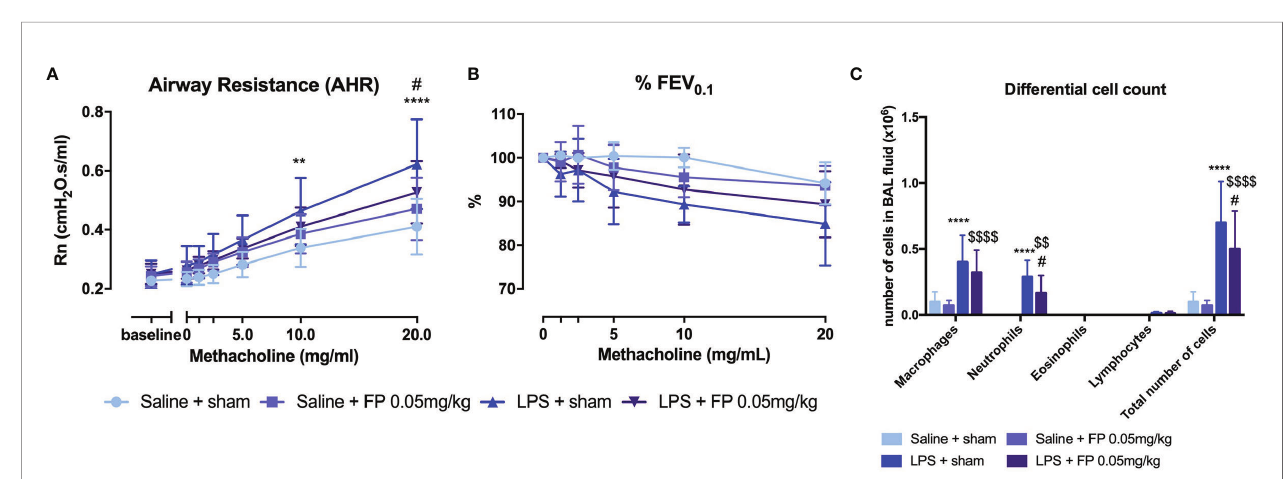
FIGURE 3 | Effect of glucocorticoid treatment in the LPS-induced asthma model. BALB/c mice were exposed to LPS (2 µg in 50 µl saline) and fl uticasone propionate (FP at 0.05 mg/kg in 50 µl) via the nose as shown in Supplementary Figure 1D . Forty-eight hours after the last challenge with LPS, lung function parameters were measured using the FlexiVent and BAL fl uid obtained for differential cell count. Airway resistance [Rn, (A) ] and FEV 0.1 [%, (B) ] before and after methacholine provocation (0 – 20 mg/ml) were measured in saline + sham-treated mice (n = 8), saline + FP-treated mice (n = 8), LPS + sham-treated mice (n = 8), and LPS + FP-treated mice (n = 8). (C) shows differential cell count in BAL fl uid. Data are represented as mean with standard deviation, and two-way ANOVA was used to calculate the p-value. **p < 0.01; ****p < 0.0001 (saline + sham versus LPS + sham). # p < 0.05; (LPS + sham versus LPS + FP). $$ p < 0.01; $$$$ p < 0.0001 (saline + FP versus LPS +